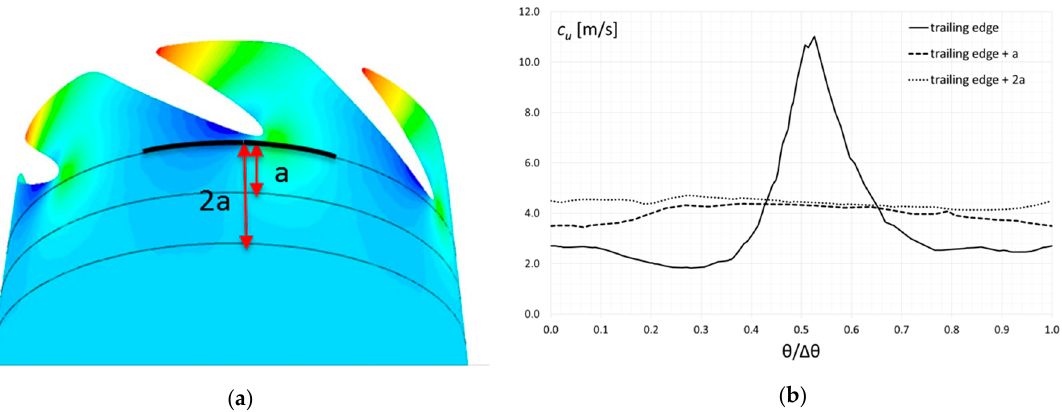
Figure 20. Local analysis of the absolute tangential velocity distribution: ( a ) representation of an arc and three different distances from the trailing edge of the blade (0, +a, +2a); ( b ) absolute tangential velocity along an arc at three different distances at the mean radius at the trailing edge of the blade at the BEP.